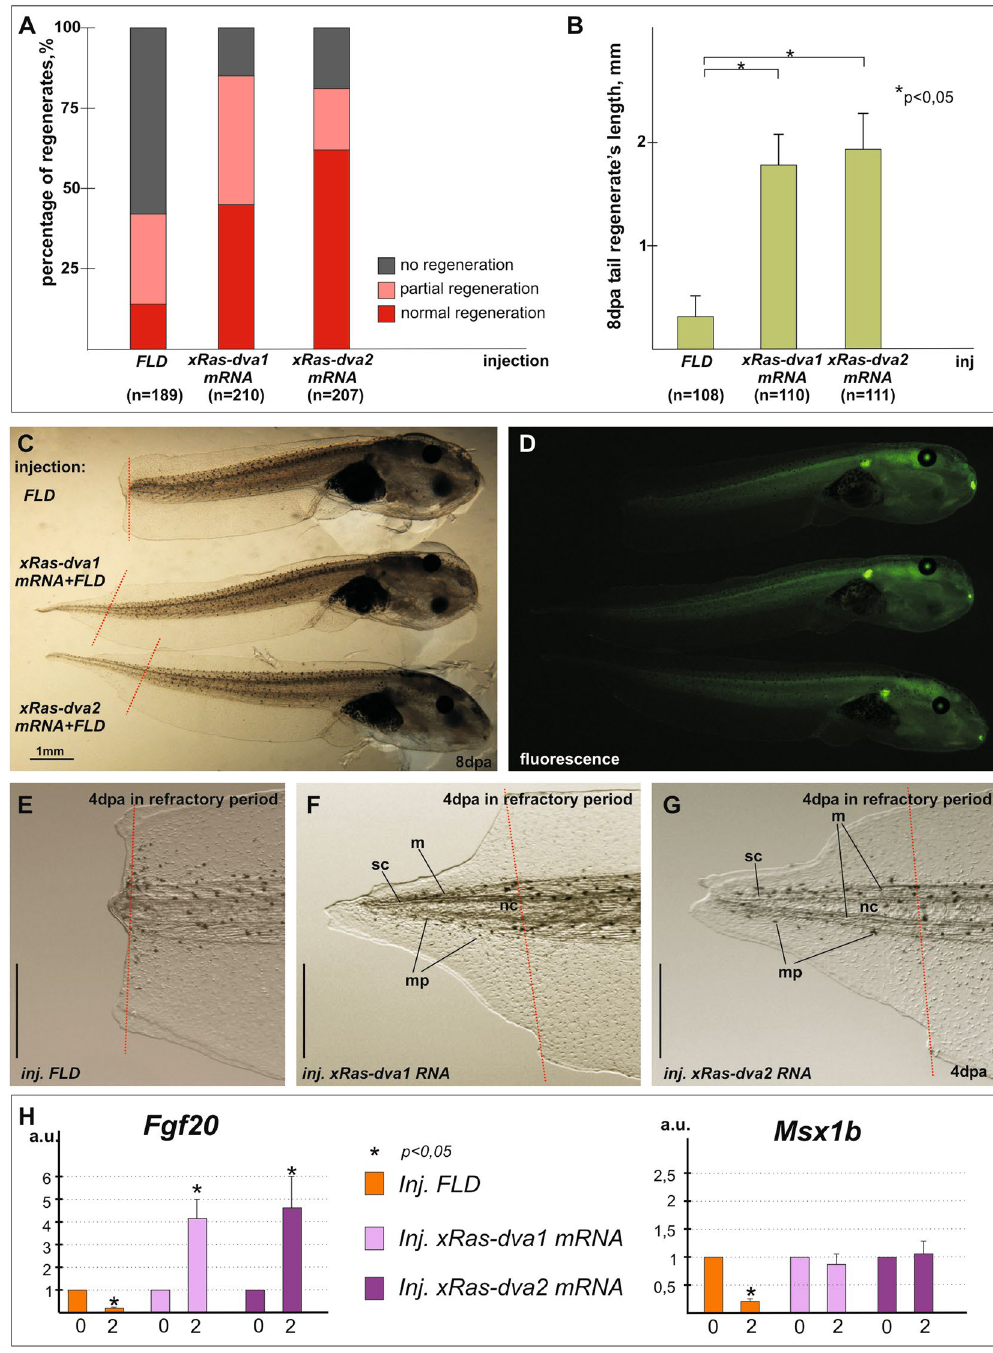
Figure 8. Rescue of the ability to regenerate tails during the refractory period in the X. laevis tadpoles. ( A ) Different rates of regeneration success in the refractory tadpoles with or without Ras-dva1/2 overexpression. The average percent mean values of regenerating tadpoles with different success rates marked by colors: gray - no regeneration, pink – partial regeneration, red – normal regeneration, in tadpole butches injected with fluorescein (FLD, as control) or overexpressing xRas-dva1 and xRas-dva2 mRNAs . n – number of injected tadpoles in three independent experiments. Differences of percent of normal regeneration between regenerates injected by FLD and mRNA are statistically significant, two-tailed t-test, p < 0,05. Percent differences of not regenerating tadpoles in FLD and mRNA injected tadpoles is statistically significant, two-tailed t-test, p < 0,05. ( B ) The measurements of the length of regenerated tail tips by 8 day after amputation of refractory tadpoles, developed from embryos injected by FLD (control) or xRas-dva1 or xRas-dva2 mRNA . n – number of injected tadpoles in three independent experiments. Two-tailed t-test, p < 0,001 (asterisk). The transmitted light ( C ) and fluorescent ( D ) images of regenerated tails of 8 dpa refractory tadpoles injected with fluorescein (FLD) or xRas-dva1 mRNA + FLD and xRas-dva2 mRNA + FLD . FLD refractory tadpoles show regeneration arrest which is common for refractory period. Refractory tadpoles with Ras-dva genes overexpression effectively regenerate their